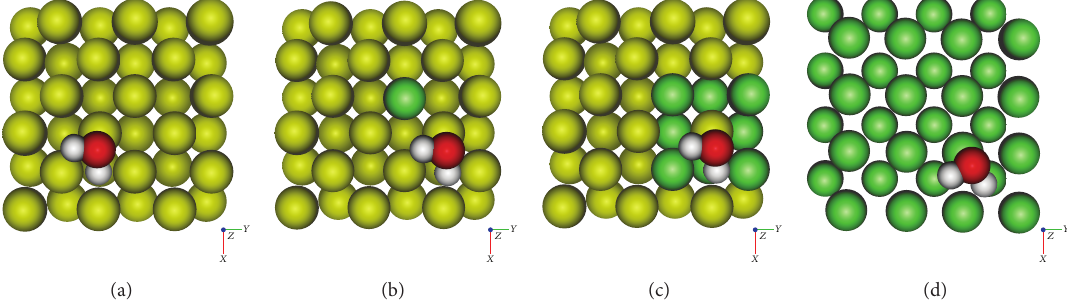
Figure 4: Water adsorbed on the surface of Ni/Fe alloy anode slab (top view) with compositions of (a) 0% Fe (pure Ni slab), (b) 2.8% Fe, (c) 22.2% Fe, and (d) 100% Fe.